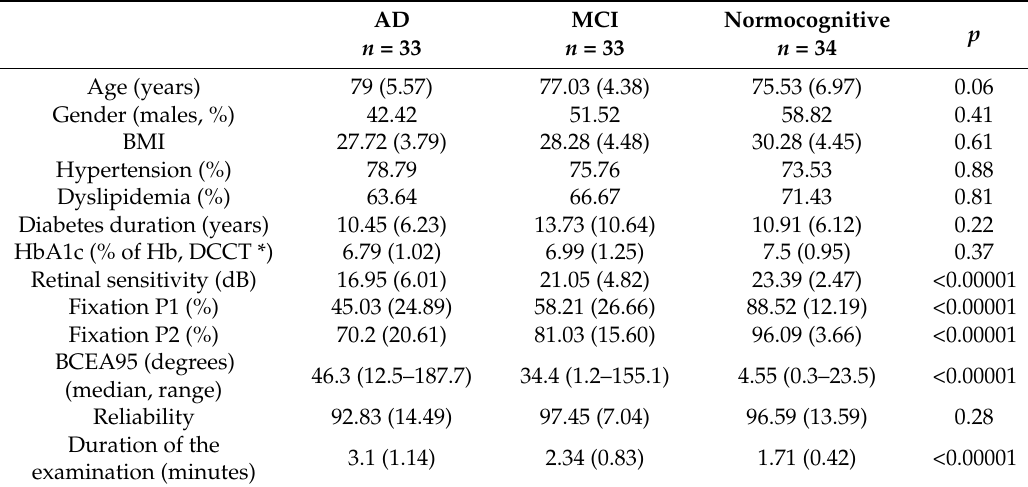
Table 1. General characteristics and parameters of retinal sensitivity and